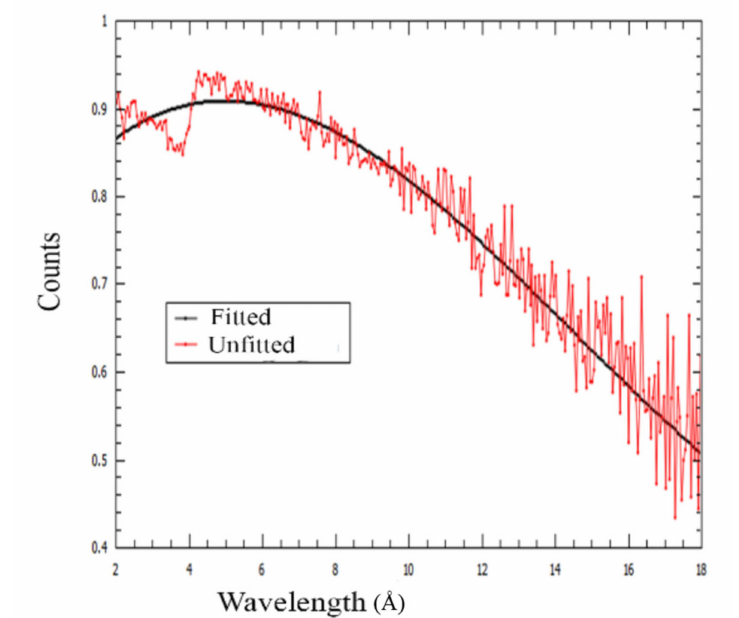
Figure A1. Transmission data from an as-quenched Fe-0.6C binary alloy. A magnetic field of 1.0 T was applied horizontally. The data show Bragg’s edge at 3.5 Å and multiple scattering above 10